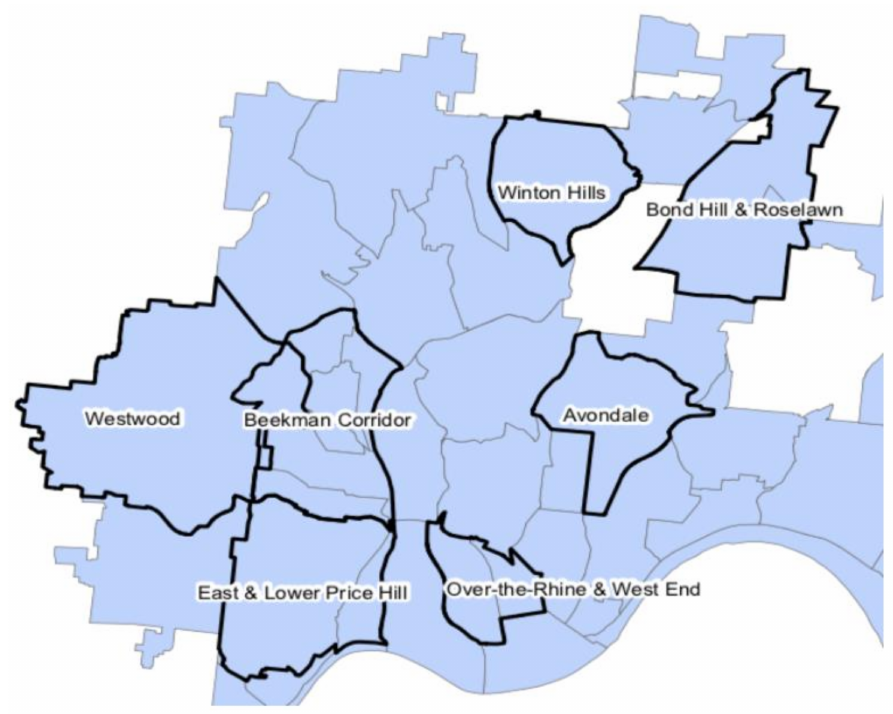
Figure 1. Cincinnati Neighborhoods